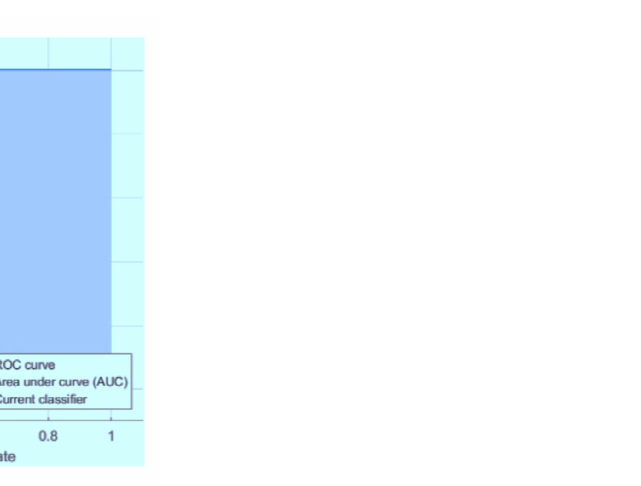
Figure 13. Receiver operating characteristic (ROC) curve for the one-dimensional convolutional neural network.